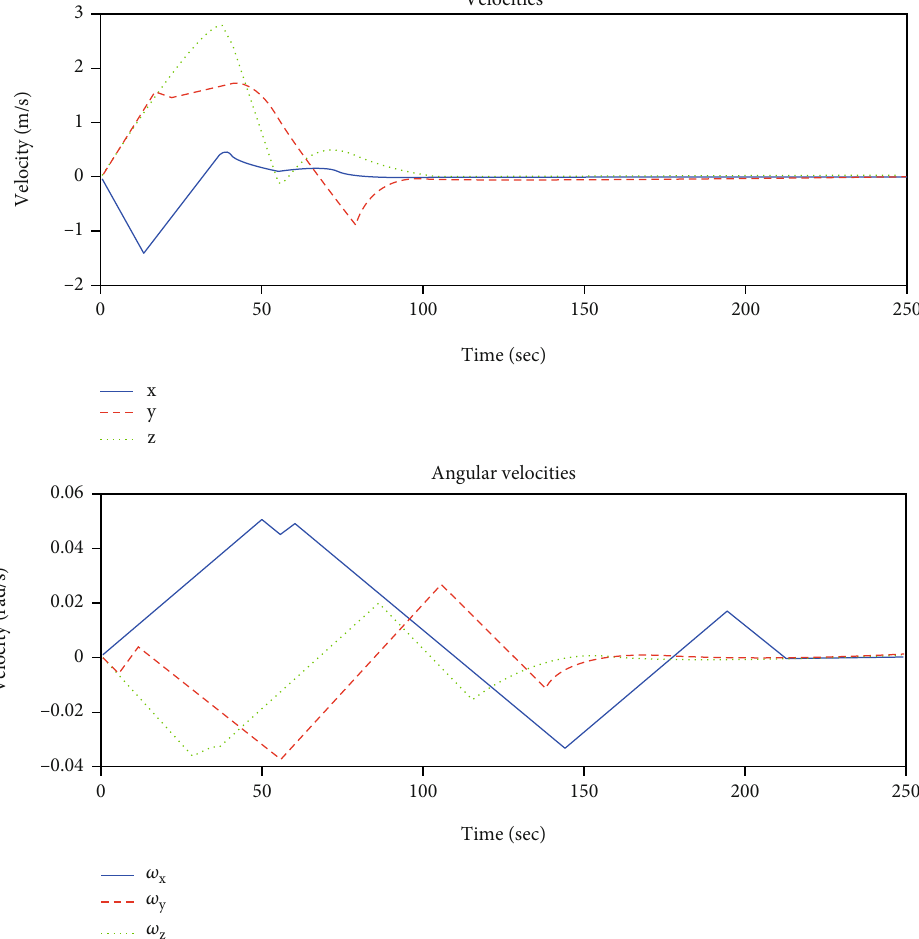
Figure 12: Time histories for the translational and rotational velocities in the body fi xed frame with the prediction of 15 sampling